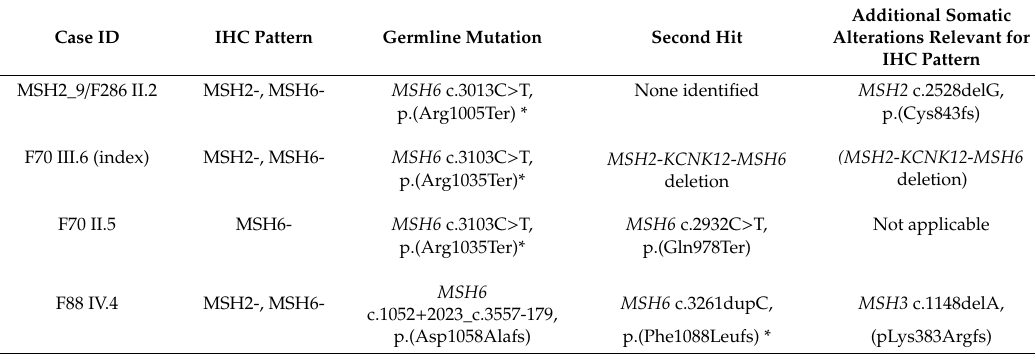
Table 1. Summary of germline and somatic alterations in patients from the MSH2-deficient cohort with tumor samples available for molecular